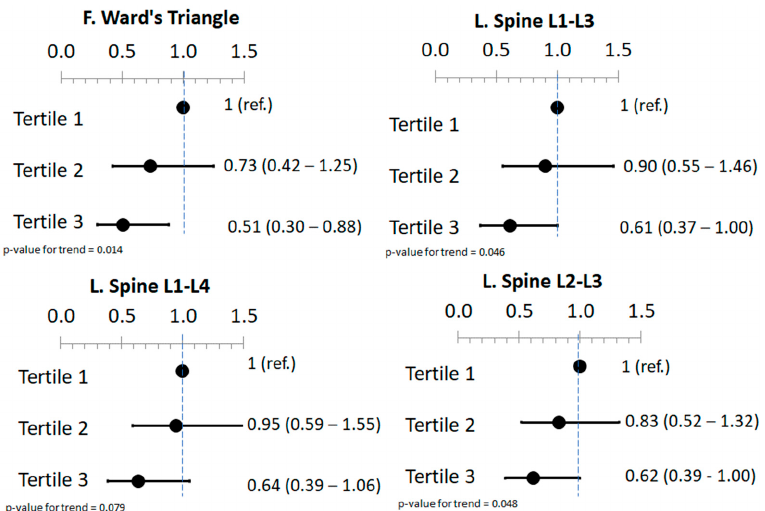
Figure 1. Forest plot of low bone mineral density (T-score ≤ − 1) and tertiles of estimated phytate intake. Values are expressed as the adjusted odds ratio (95% CI). Models were adjusted for age (years), BMI (kg/m 2 ), physical activity (MET • min/week), educational level (higher education/technician or secondary education/primary education or less), smoking status (never/former/current), type 2 diabetes prevalence, osteoporotic fractures prevalence, energy (kcal/day), calcium (mg/day), vitamin D ( µ g/day), glycemic index, vegetables and fruits (g/day). This figure is a summary of the Supplementary Table S1. Table 6. Association of bone mineral density (T-score) in lumbar spine L1–L4 and estimated phytate intake (by tertiles and per each 25 mg/100 kcal) by subgroups. Tertile 1 <15.0